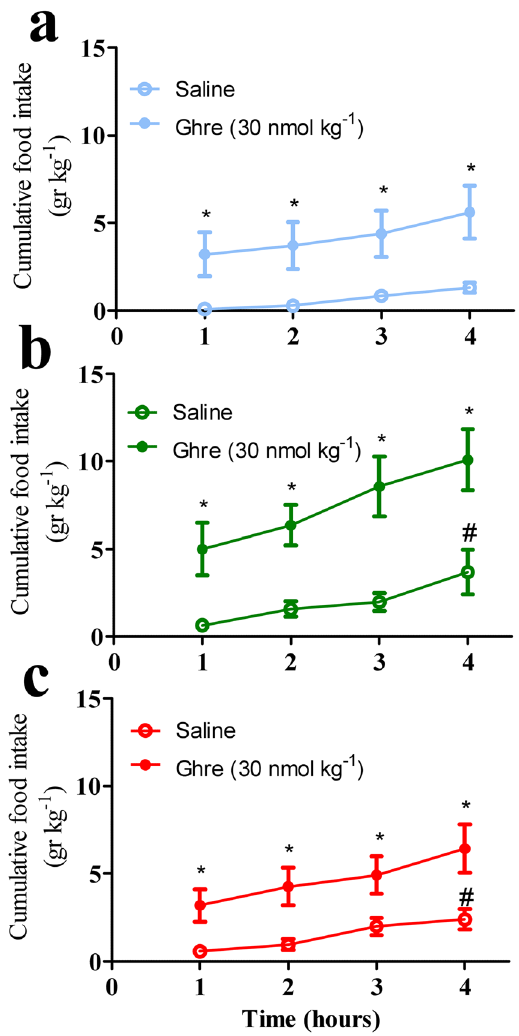
Figure 5. Effect of ghrelin on cumulative food intake. ( a ) Control group; ( b ) Obstructive group; ( c ) Obstruction removal group. Open symbols are mean cumulative 4 h food intake after saline administration and closed symbols follow administration of ghrelin (30 nmol kg − 2 ) on the following day. Blue color – control, green color – obstructive group, red color – obstruction removal. Error bars are s.d. * p < 0.05 statistical difference between saline and ghrelin were determined by two-way ANOVA followed by Student-Newman-Keuls test. # p < 0.05 difference between AO and obstruction removal